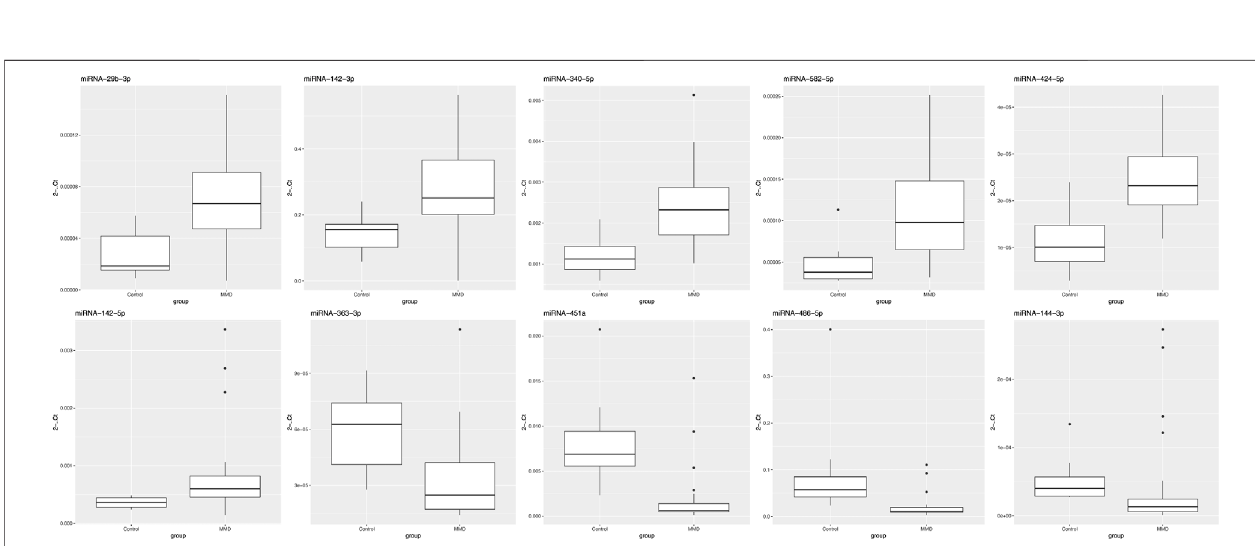
FIGURE 4 | Validation of differentially expressed miRNAs between MMD patients and healthy controls using quantitative real-time PCR. In this analysis, 7 miRNAs had differential expression in MMD patients, of which miRNA-29b-3p, miRNA-142-3p, miRNA-340-5p, miRNA-582-5p were upregulated, while miRNA-363-3p, miRNA-451a, miRNA-486-5p were